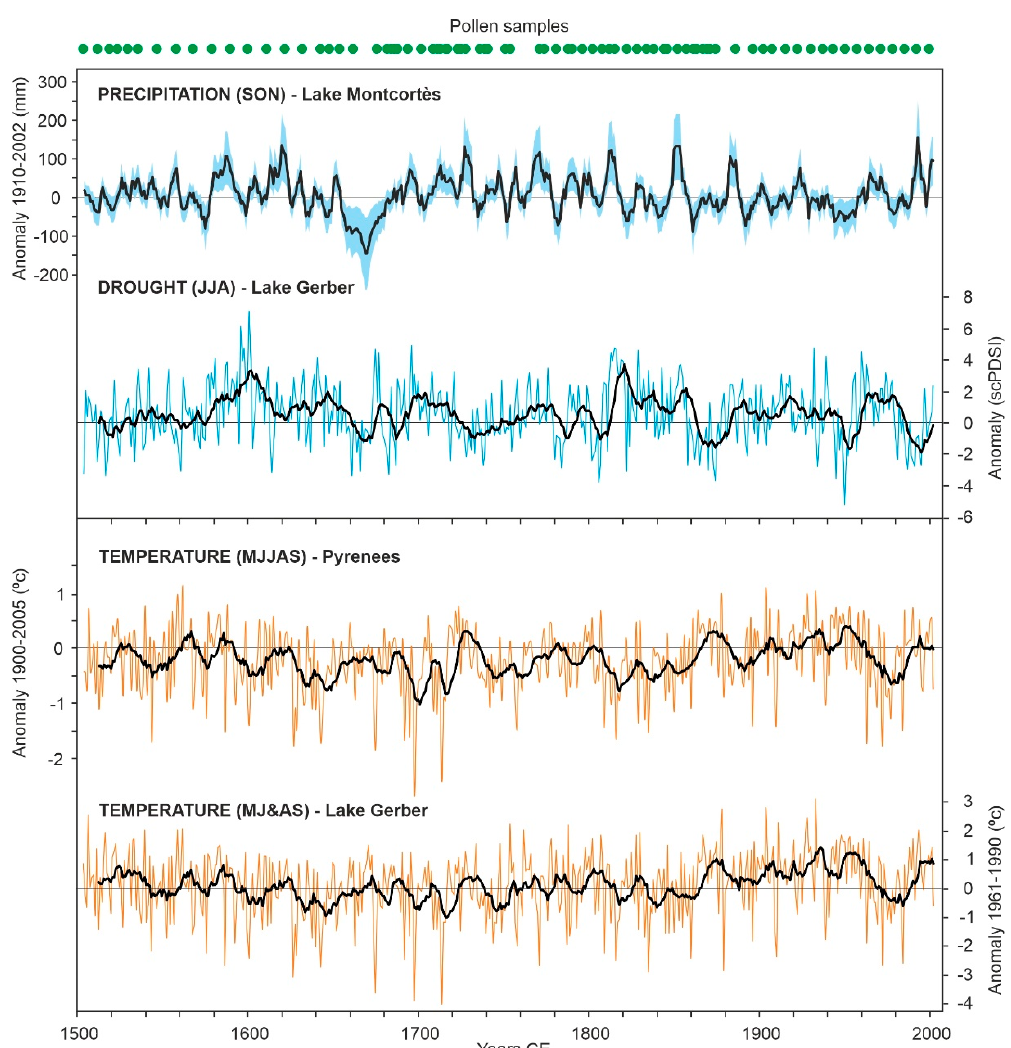
Figure 6. Paleoclimatic reconstructions inferred from pollen-independent proxies in the sediments of Lake Montcortès and other Pyrenean lakes. Values are provided in terms of anomalies with respect to the instrumental records of the periods indicated. In the case of summer drought intensity, the anomalies are relative to the self-calibrated Palmer drought indices (scPDSIs) for the Mediterranean region (see the original reference). Samples for pollen analysis are indicated in the upper part for reference. Precipitation (Lake Montocrtès) after ref. [46], drought (Lake Gerber) after ref. [44], upper temperature series (Pyrenees) after ref. [43] and lower temperature series (Lake Gerber) after